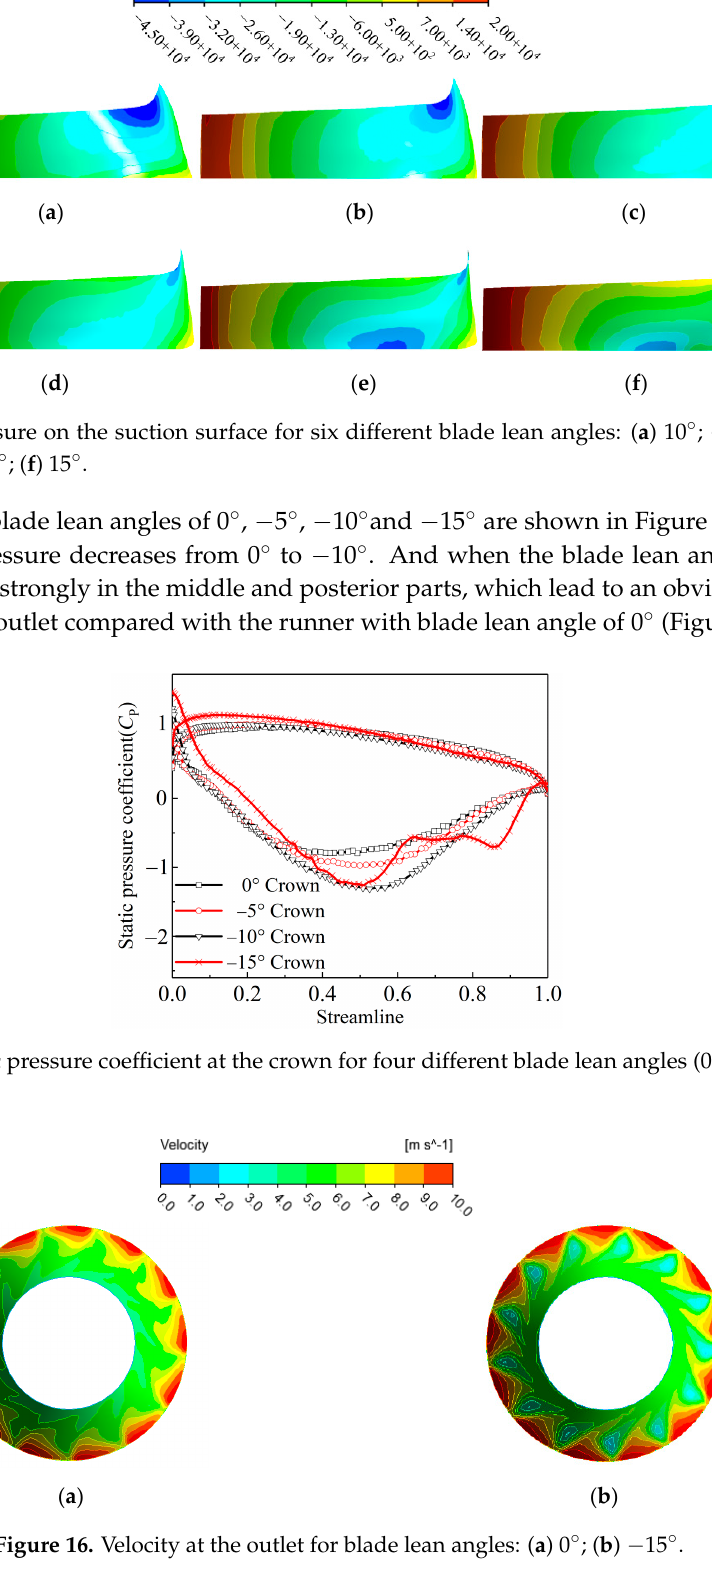
Figure 16. Velocity at the outlet for blade lean angles: ( a ) 0°; ( b ) − 15°.